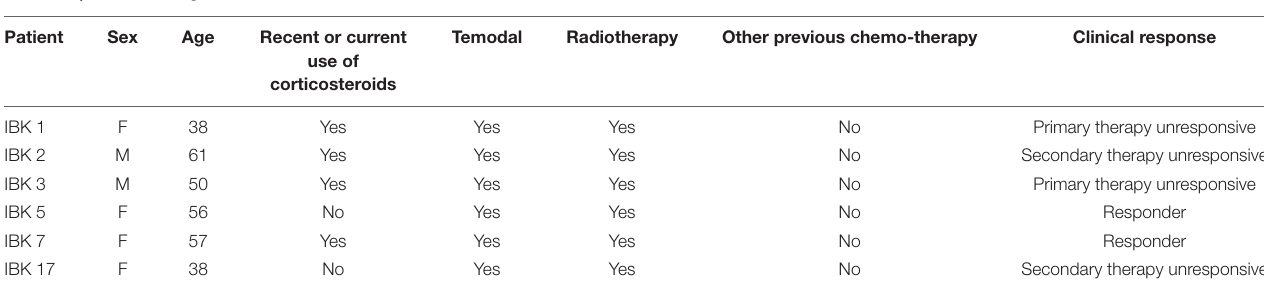
FIGURE 5 | Serial serum samples from the patient cohort described in Table 1 were tested for the presence of circulating levels of bevacizumab using an ELISA (Panel A) as described in the section “Materials and Methods.” The same samples were also tested for bevacizumab VEGF neutralizing activity (Panel B) and bevacizumab ADCC activity (Panel C) as described in the section “Materials and Methods.” To eliminate possible non-specific effects, the ADCC activity of each serum sample was first determined using both mVEGF (+) and mVEGF( − ) target cells and the values obtained in the presence of the mVEGF( − ) target cells were subtracted from those obtained using the mVEGF (+) and the final results were determined by interpolation of the standard curve of bevacizumab activity ( Figure 3 , Panel A) using the Prism software (GraphPad, France). The values obtained for the circulating levels of bevacizumab determined by ELISA were compared with the values obtained for the neutralization of VEGF activity (Panel D) or the values obtained for the ADCC activity of bevacizumab were compared with the values obtained for the neutralization of VEGF activity (Panel E) or the circulating levels of bevacizumab determined by ELISA (Panel F). TABLE 1 | Patients with glioblastoma: Treatment